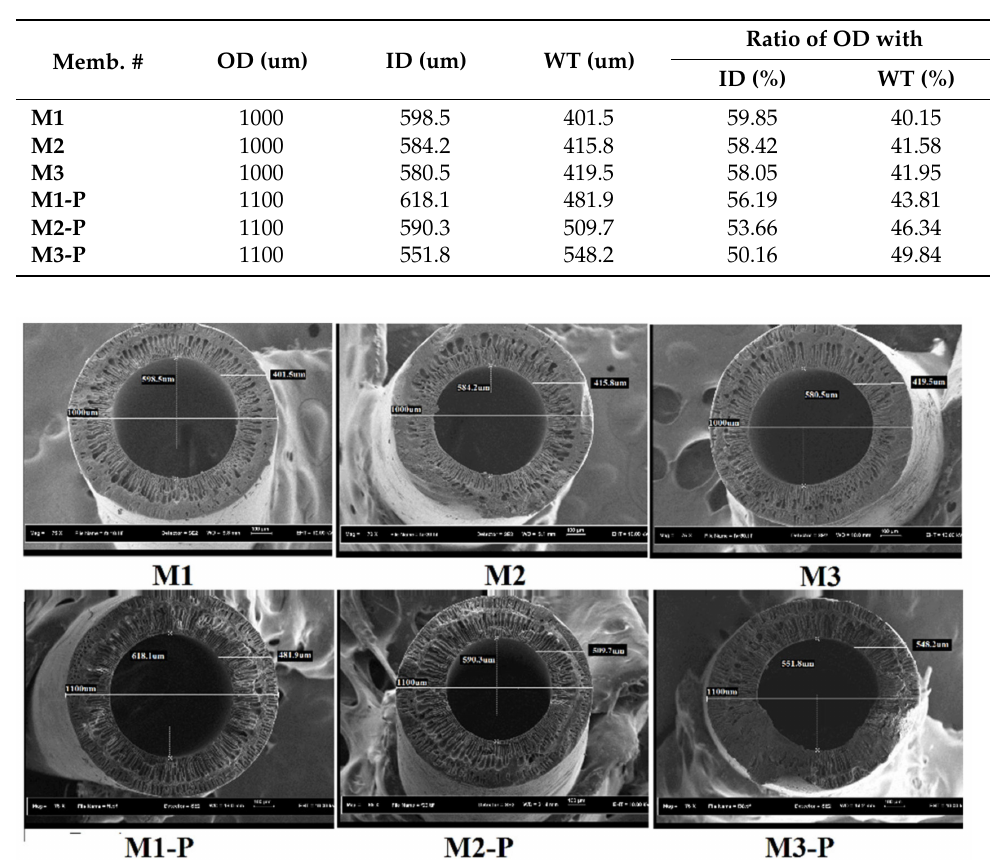
Figure 3. The FESEM cross-section results with dimension calculations (i.e., outer diameter, wall thickness, and inner diameter in